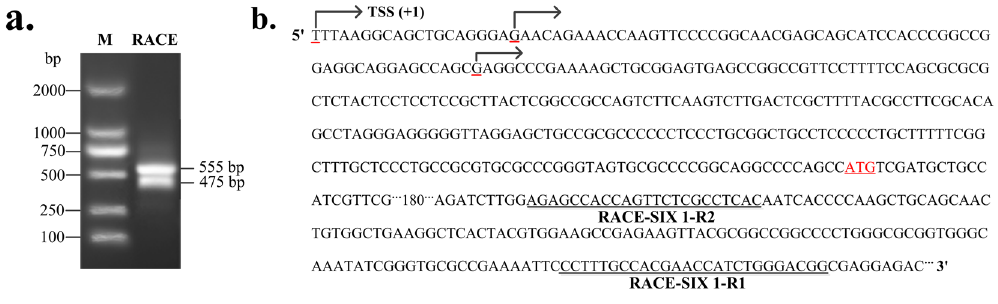
Figure 2. Results of 5 ′ RACE analysis of the SIX1 cDNA from skeletal muscle. ( a ) Products of the 5 ′ RACE of the SIX1 (arrow) from nested PCR were analysed by agarose gel electrophoresis. ( b ) Sequence of the SIX1 mRNA region. The primers (R1 and R2) were used for the 5 ′ RACE analysis are underlined. The positions of identified TSS are marked with arrows and red underline. The translational start site (ATG) is shown in red letters.